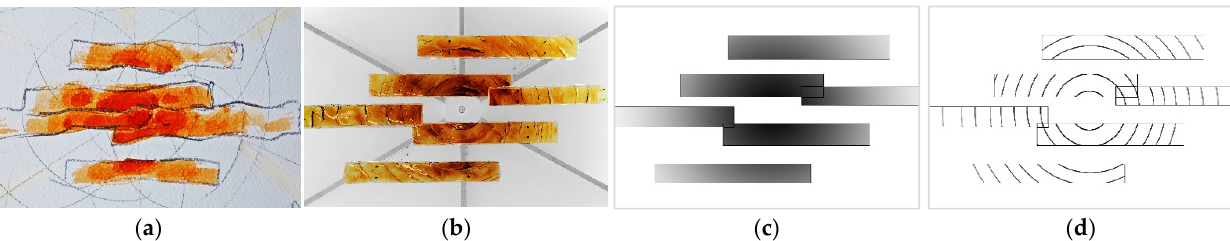
Figure 6. The Spirit of Health suspended glass art composition at the Integrative Medical Center in Żerniki Wrocławskie, Poland, 2018: ( a ) watercolor project (Tomasz Urbanowicz); ( b ) finished project (Tomasz Urbanowicz and Konrad Urbanowicz); ( c ) glass background color intensity; ( d ) glass relief color and structure (Konrad Urbanowicz).